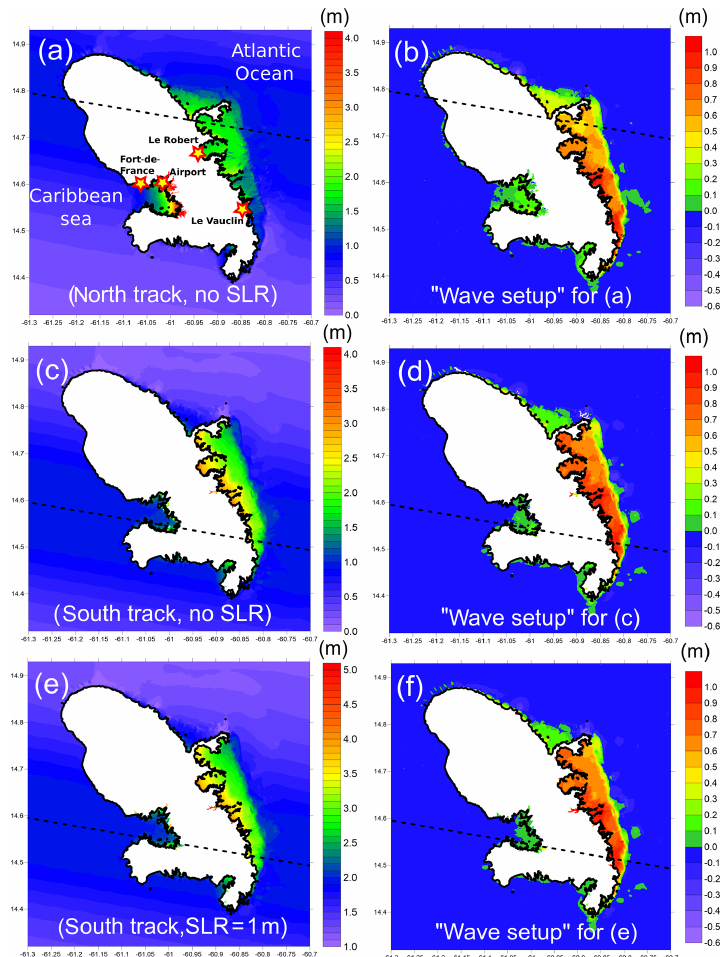
Figure 5. Maximum water levels (left) and wave setup (right) for three worst case (category 4–5) hurricanes: northern track and no sea level rise (a, b) , southern track and no sea level rise (c, d) , and southern track with 1m sea level rise (e, f) . The dashed black lines represent the track of the cyclone for each scenario. “Wave setup” refers here to the difference between the maximum water levels with and without waves. Note that the wave setup “peaks” offshore the northwest coast are probably due to small numerical instabilities in SWAN in a region with strong lateral bathymetric variations. Fortunately these errors are found to be very small (1cm maximum) and bear no consequences on the results presented in this paper.